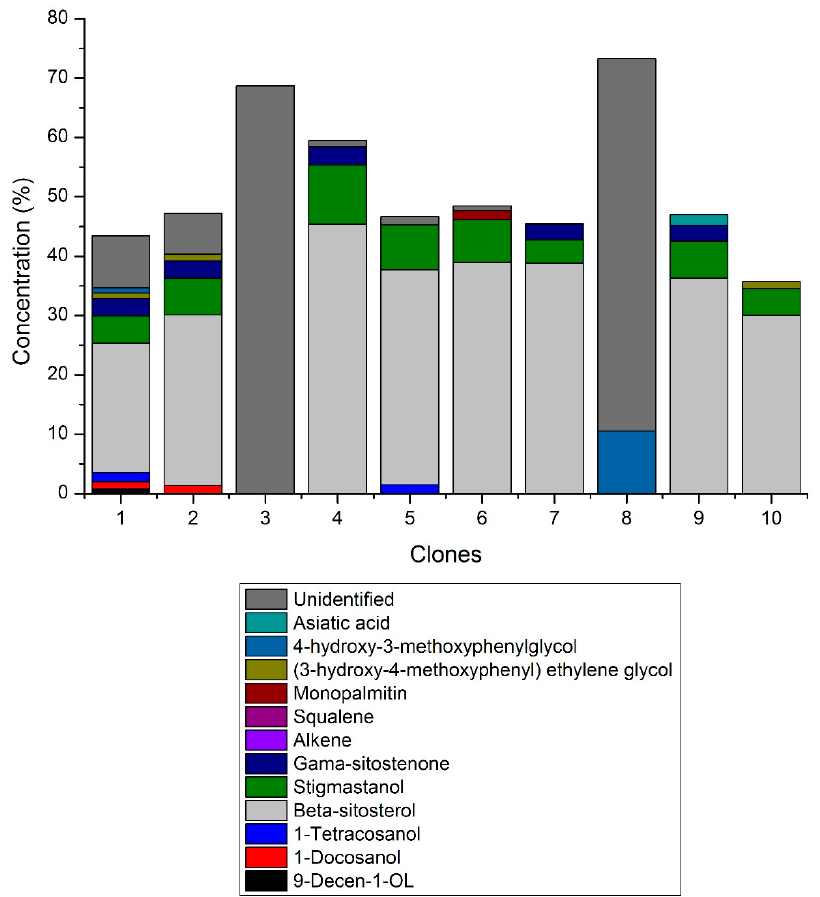
Figure 6. Fatty alcohol concentration (9-decen-1-ol, 1-docosanol, 1-tetracosanol); steroids ( β -sitosterol, stigmastanol, γ -sitostenone, alkene, squalene); glycerol derivatives (monopalmitin, 3-hydroxy-4-methoxyphenyl ethylene glycol, 4-hydroxy-3-methoxyphenylglycol) and triterpenes (Asian acid) identified in the lipophilic fraction of Eucalyptus spp. clones extracted with dichloromethane. Substituted alkanoic acids were identified in the lipophilic extracts, with an average content of 9.9% among the evaluated clones. Trans-9-octadecanoic acid and 9,12-octade- canoic acid were also identified (Figure 7).